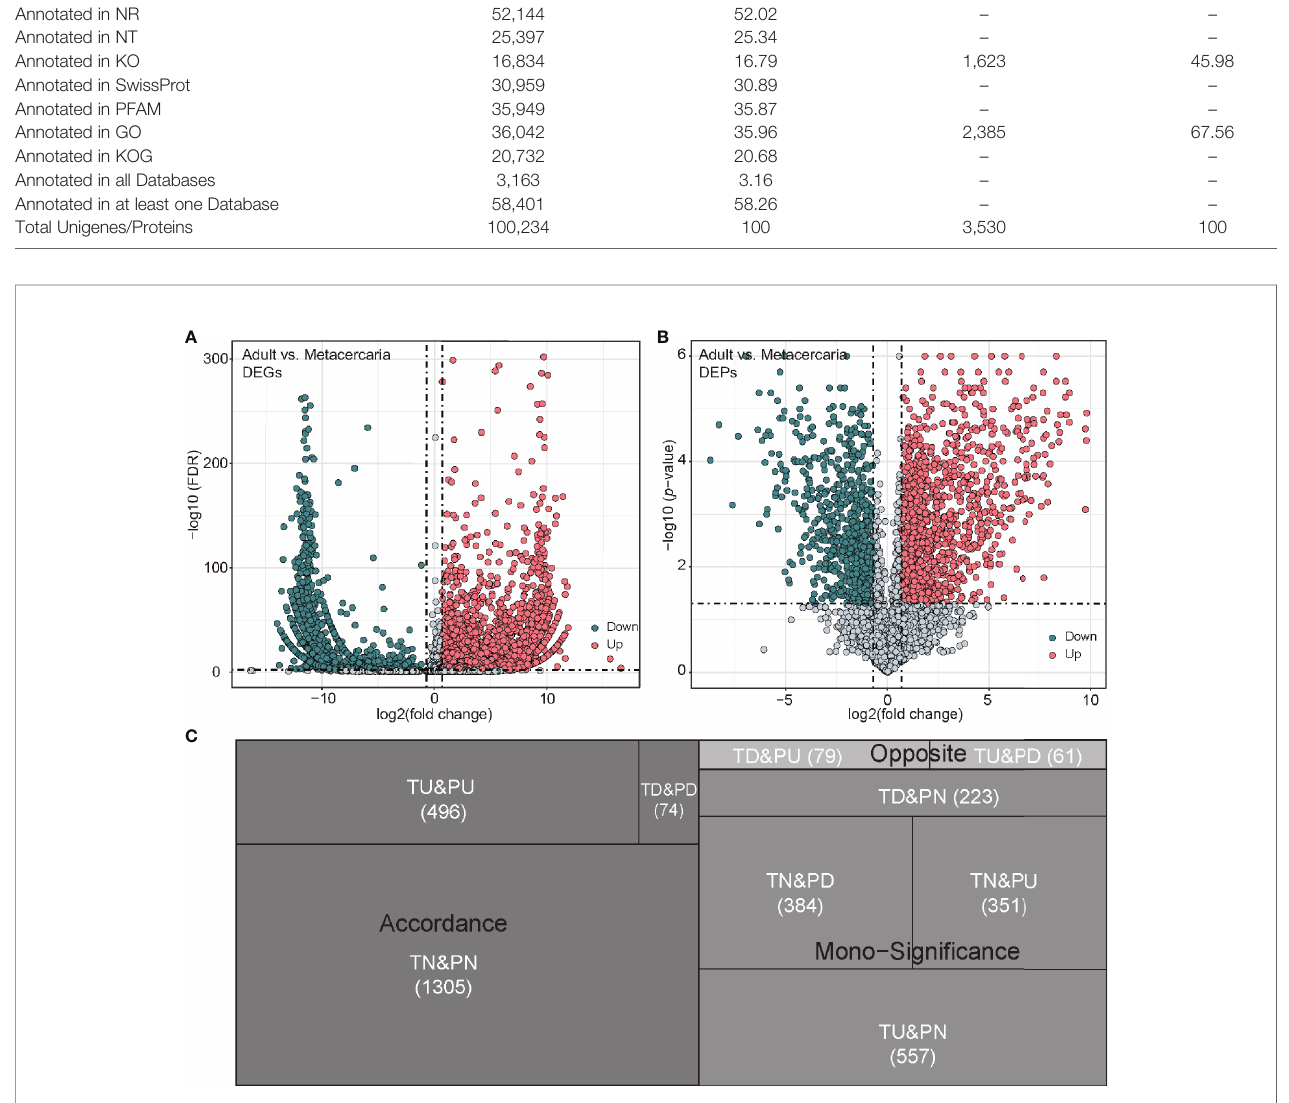
FIGURE 1 | Differentially expressed genes (DEGs) and differentially expressed proteins (DEPs) between adult stage and metacercariae stage. (A, B) presented DEGs and DEPs volcanoes, respectively. The differential expression cut-off of mRNA was FDR < 0.005 and 2-fold change, while the differential expression cut-off of protein was p -value <0.05 and 2-fold change. (C) The tree diagram shows the results of mRNA and protein co-expression. TU, TD and TN represent up-regulated, down- regulated and unchanged mRNA, respectively. PU, PD and PN represent up-regulated, down-regulated and unchanged protein,